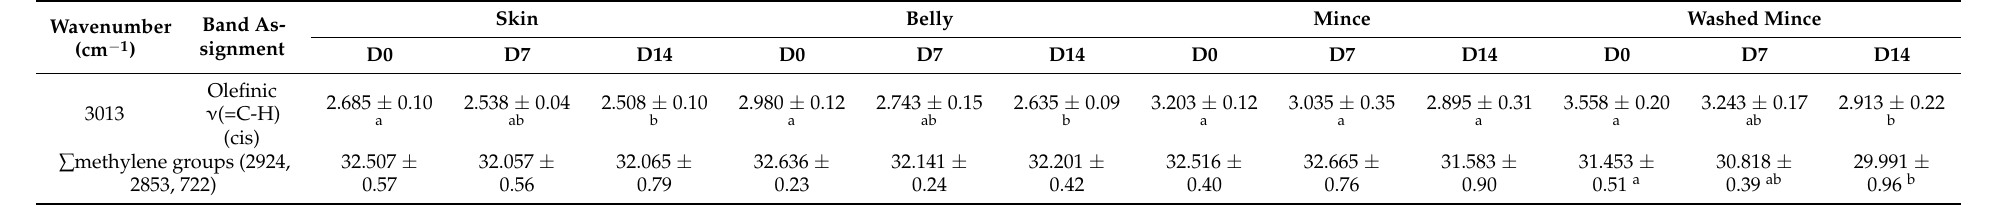
Table 5. Relative integrated intensity of selected regions of Fournier transforms infra-red (FT-IR) spectra of extracted lipid samples from various tissues of silver carp during ice storage and their respective washed